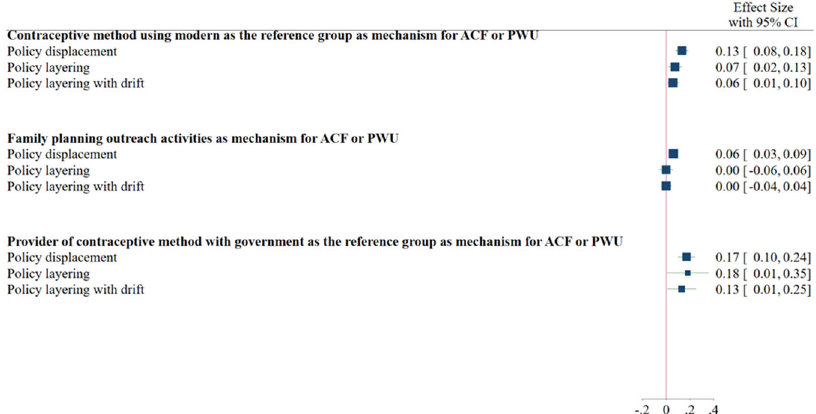
Fig. 6 Contraceptive method-modern, family planning outreach activities, and provider of contraceptive methods-government between policy displacement, policy layering, and policy displacement with layering and drift and induced pregnancy terminations (after a contraceptive failure (APC)), or pregnancy was undesired